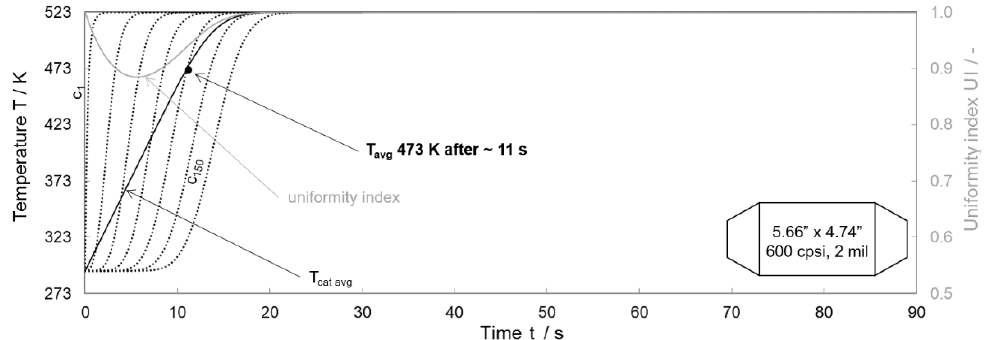
Figure A3. Heat-up of 600 cpsi, 3 mil with reduced length at steady state heat-up.